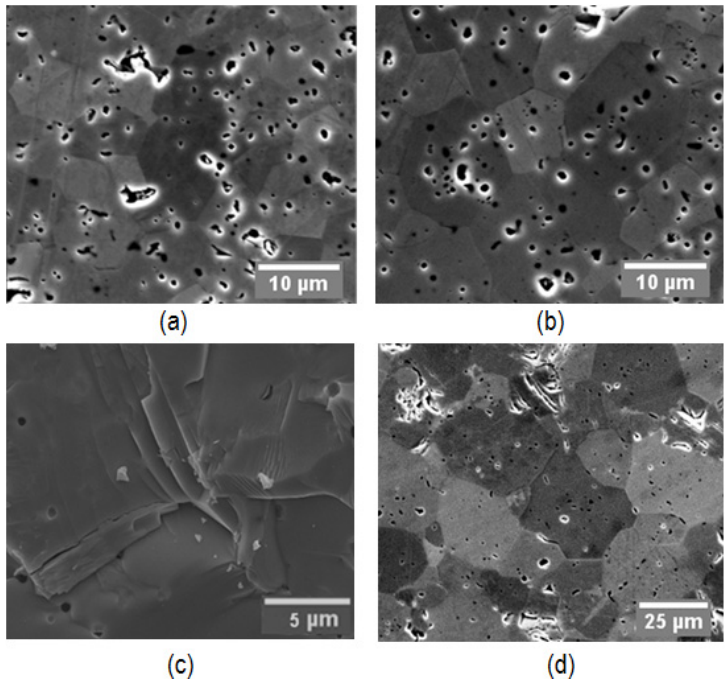
Figure 5. SEM images of fracture surfaces: ( a ) Single-die SPS at 1800 ˝ C, Specimen #3; ( b ) Single-die SPS at 1900 ˝ C, Specimen #2; ( c ) Single-die SPS at 2100 ˝ C, Specimen